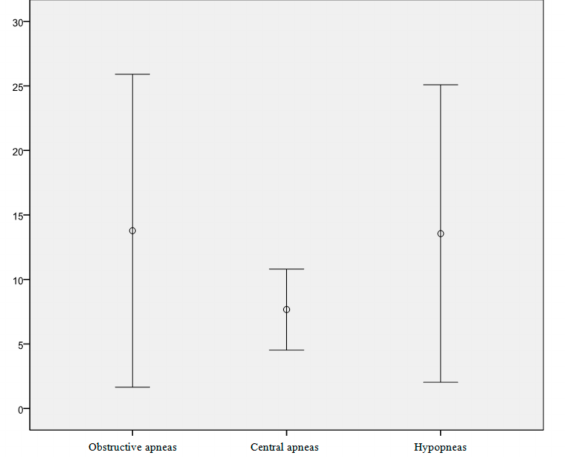
Figure 2. Mean numbers of obstructive apnoea, central apnoea, and hypopnea recorded in the studied